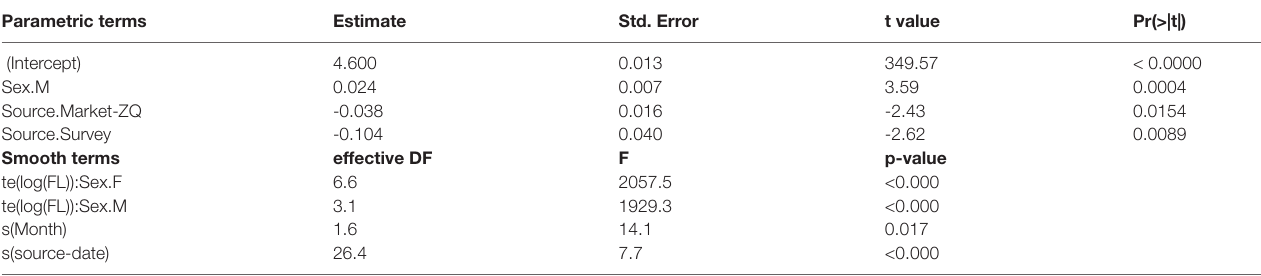
TABLE 3 | Significance table for factor (top table) and smooth (bottom table) terms in the best length-weight relationship model: log(BW) ~ te(log(FL), k = 30, by = sex) + sex + s(year-fraction, bs = “cc”) + source + s(source-date, bs = “re”). Parametric terms